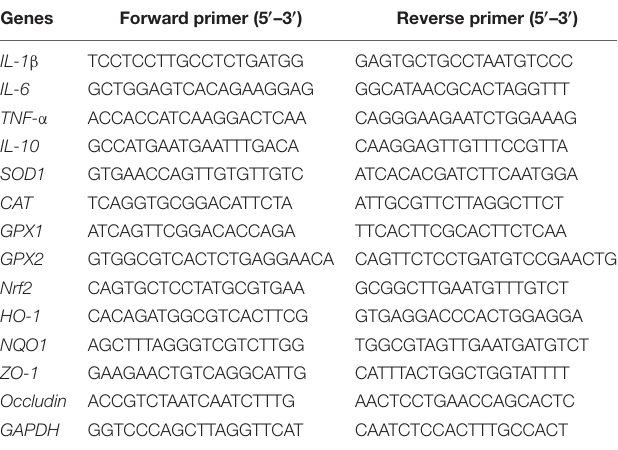
TABLE 1 | Primers used for qPCR assay. Genes Forward primer (5 (cid:48) –3 (cid:48) ) Reverse primer (5 (cid:48) –3 (cid:48)